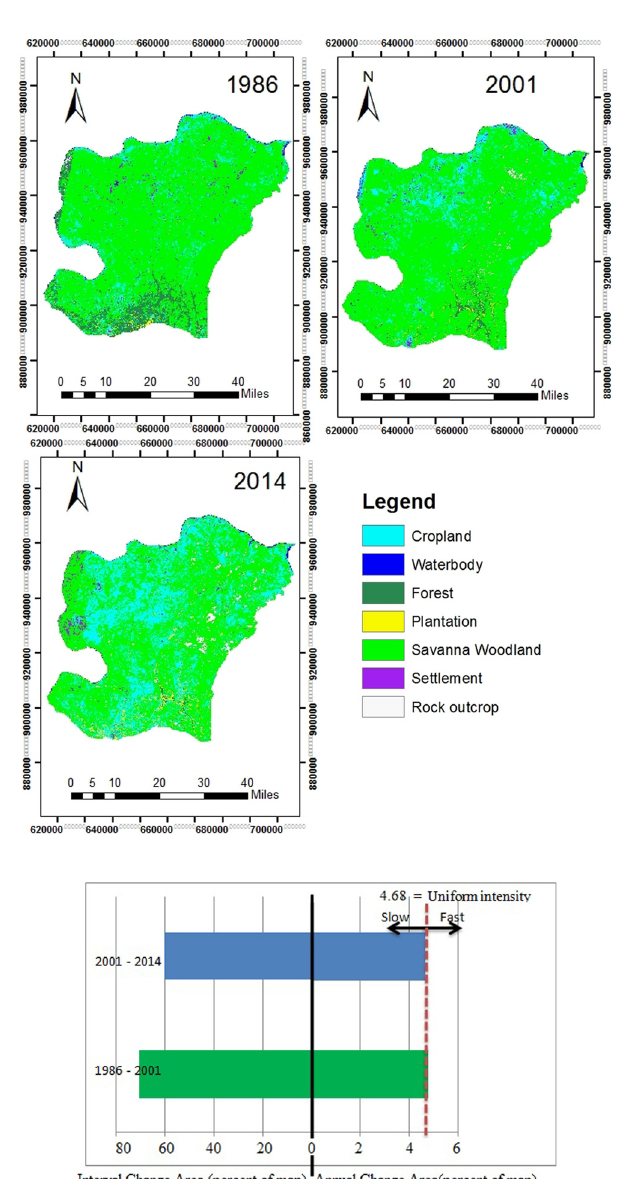
Figure 3. Interval intensity analysis for two time intervals: 1986-2001 and